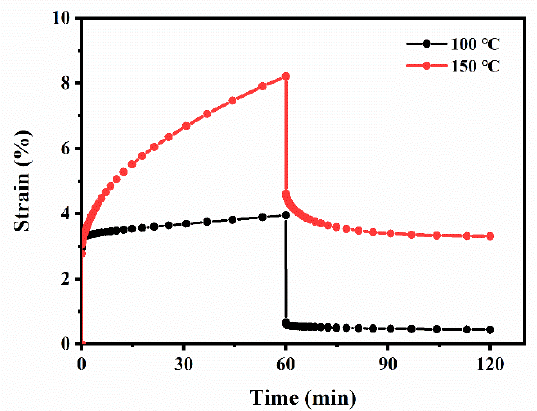
Figure 9. Creep recovery curves of vitrimer 4 at 100 °C and 150 °C.